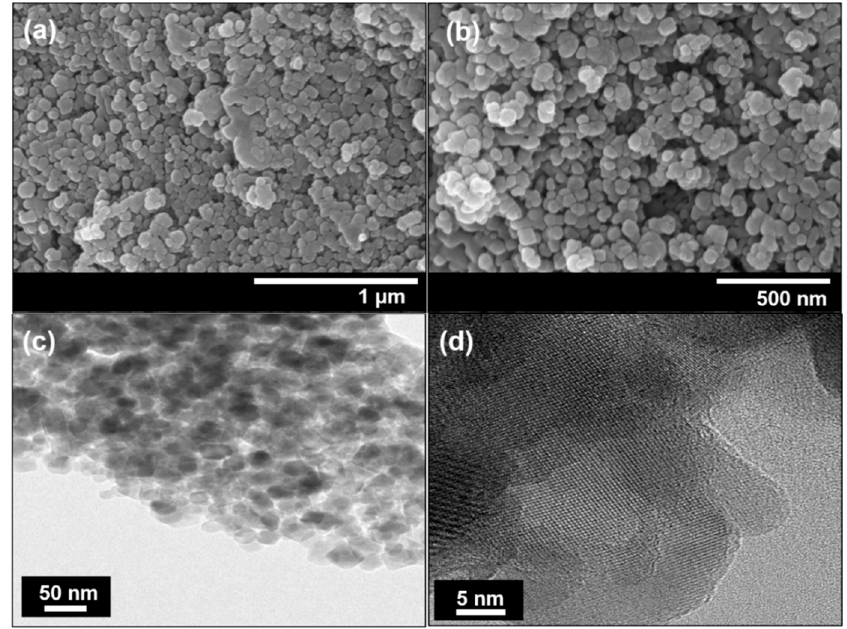
Figure 1. The ( a , b ) FESEM, ( c ) TEM and ( d ) HRTEM images of the synthesized mesoporous Mn 2 O 3 materials. Mn 2 O 3